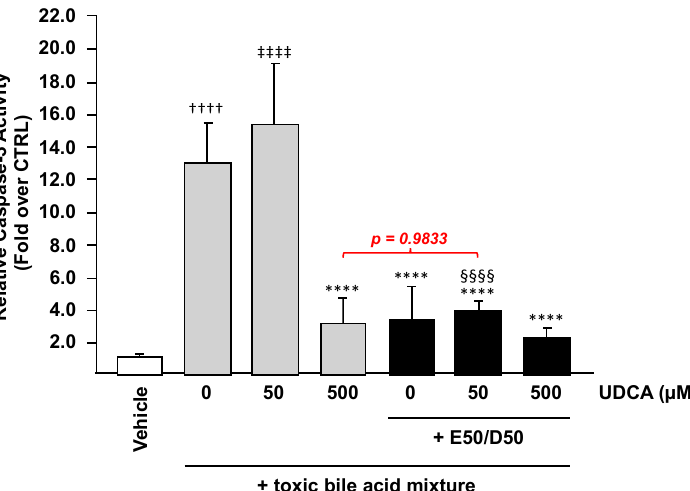
Figure 2. EPA and DHA protect liver cells against bile acid-induced apoptosis in the presence of UDCA. HepG2 cells were treated with vehicle (DMSO), EPA/DHA, UDCA, or a combination of EPA/DHA + UDCA at the indicated doses for 24 h, and subsequently exposed for 2 h treatment to the vehicle or a toxic BA mixture (CA, CDCA, LCA, and DCA, 100 µM each), caspase 3 activity was then quantified as detailed in the materials and methods section and expressed relatively to control cells set at 1. Data represent the mean of two independent experiments in which each treatment was performed in quadruplicate. Each data point therefore corresponds to the mean of 8 replicates ± SD. Statistical significances as determined by a one-way ANOVA followed by Tukey’s multiple comparison post-hoc were as follows: Untreated cells exposed to vehicle vs. untreated cells exposed to bile acids: †††† p < 0.0001; Vehicle cells vs. UDCA treated cells: ‡‡‡‡ p < 0.0001; BA exposed cells vs. BA + UDCA ± EPA/DHA exposed cells: **** p < 0.0001; UDCA treated cells vs. UDCA + EPA/DHA treated cells: §§§§ p < 0.0001; E50:D50: EPA 50 µM and DHA 50 µM.